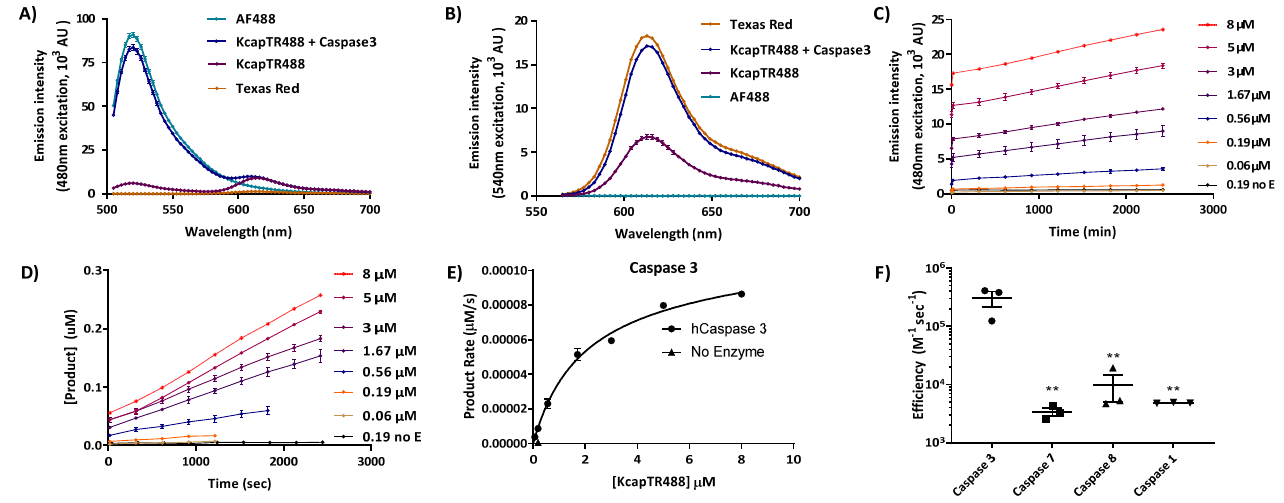
Figure 1. Changes in FRET between fluorophores in KcapTR488 reporter detected caspase activity in vitro. Emission scan for AF488, KcapTR488 with Caspase 3, KcapTR488, and Texas Red at excitation wavelengths of 480 nm ( A ) and 540 nm ( B ) revealed two-way FRET between AF488 and Texas Red. The emission peak of KcapTR488 at 520 nm increased 13.92 ± 0.04 (SD) fold when caspase 3 was added ( A ). The addition of caspase 3 also increased KcapTR488 emission at 613 nm by 2.54 ± 0.13 (SD) fold at the excitation wavelength of 540 nm ( B ). Caspase 3 (0.14 nM) was incubated with various concentrations of substrate KcapTR488, and the emission at 520 nm (excitation at 480 nm) was recorded over time ( C ). The products ( D ) and initial rate ( E ) of enzymatic caspase 3 cleavage were calculated based on the nonlinear fitting of a concentration of cleaved product to the observed emission ratio at each time point. Caspases 7, 8, and 1 were also tested using the same experimental design. The catalytic efficiency, Kcat/Km, was calculated for all four caspase enzymes ( F ), which indicated that caspase 3 was the preferred enzyme for KcapTR488. ** represents p<0.01. Table 1. Summary of biochemical characterization of